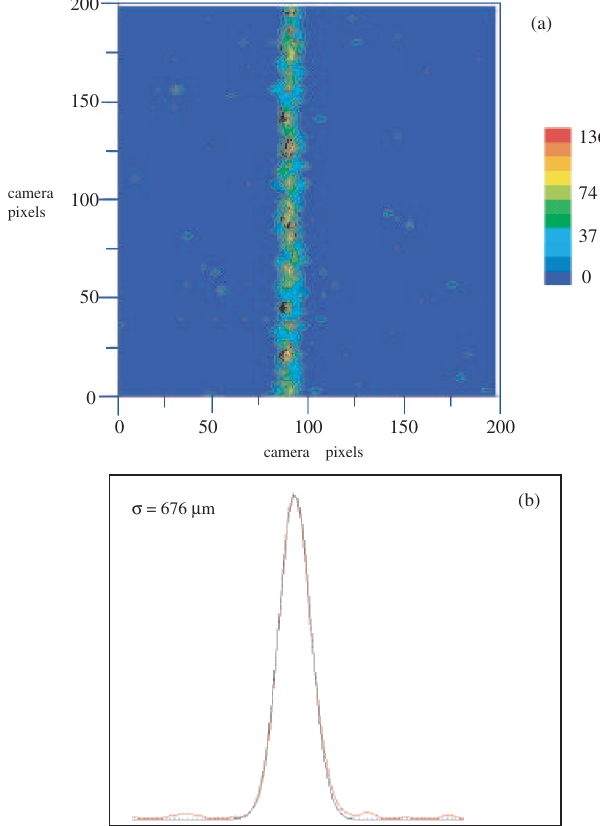
FIG. 6. (Color) (a) Display of the proton beam scintillation path (the display is similar for the H and V plane owing to camera orientation). (b) Vertical profile obtained by projection on the horizontal axis on which the result of the Gaussian fit is super- imposed. The measurement conditions were beam (cid:1) (cid:6) 676 (cid:5) , beam current 140 mA, 2 (cid:5) 10 13 protons, beam energy (cid:6) 450 GeV , and nitrogen pressure (cid:6) 5 (cid:5) 10 (cid:2) 7 Torr .